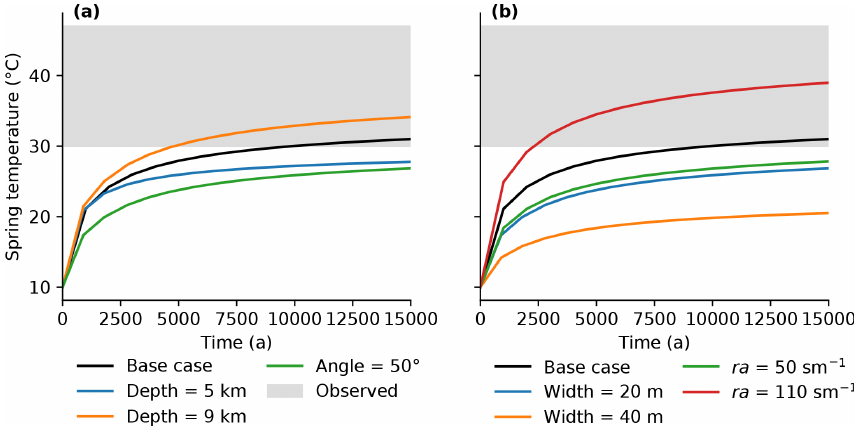
Figure 6. Modelled spring temperatures over time and sensitivity of spring temperatures to the geometry of the fluid conduit and the heat flux at the land surface. The observed present-day temperatures in the springs range from 30 to 47 ◦ C (Sonney and Vuataz, 2008). The base case model uses a fluid conduit depth of 7km, a width of 10m, an angle of 65 ◦ , and a value of aerodynamic resistance ( r a ), which governs the heat flux at the land surface, of 80sm − 1